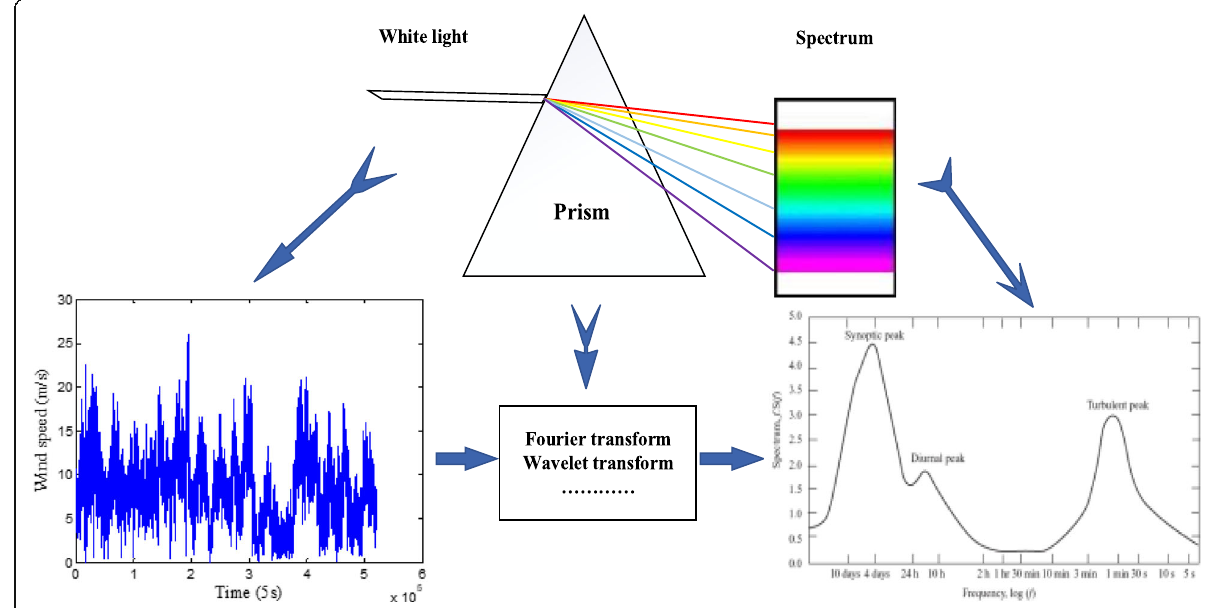
Fig. 1 Schematic of the spectral obtained using the characteristics analysis